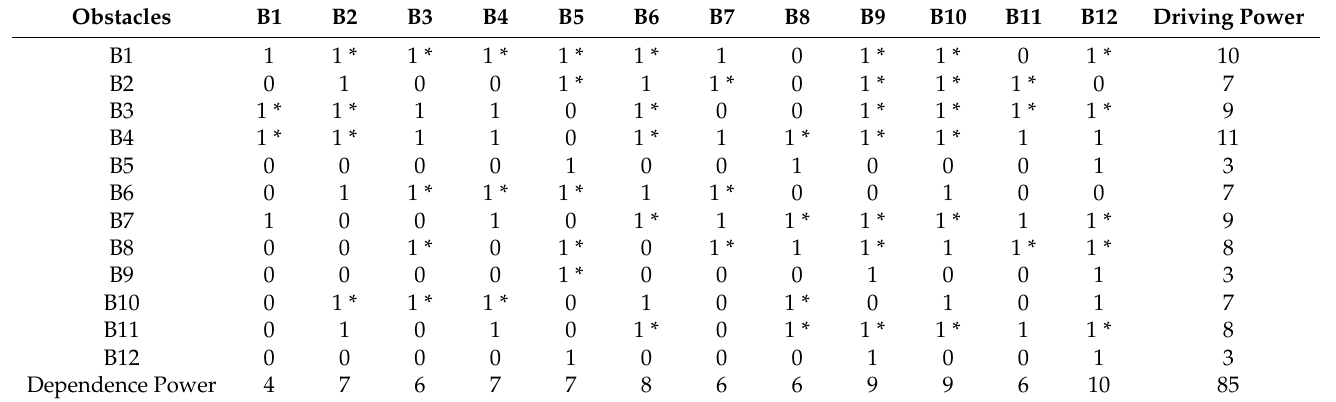
Table 9. Final reachability